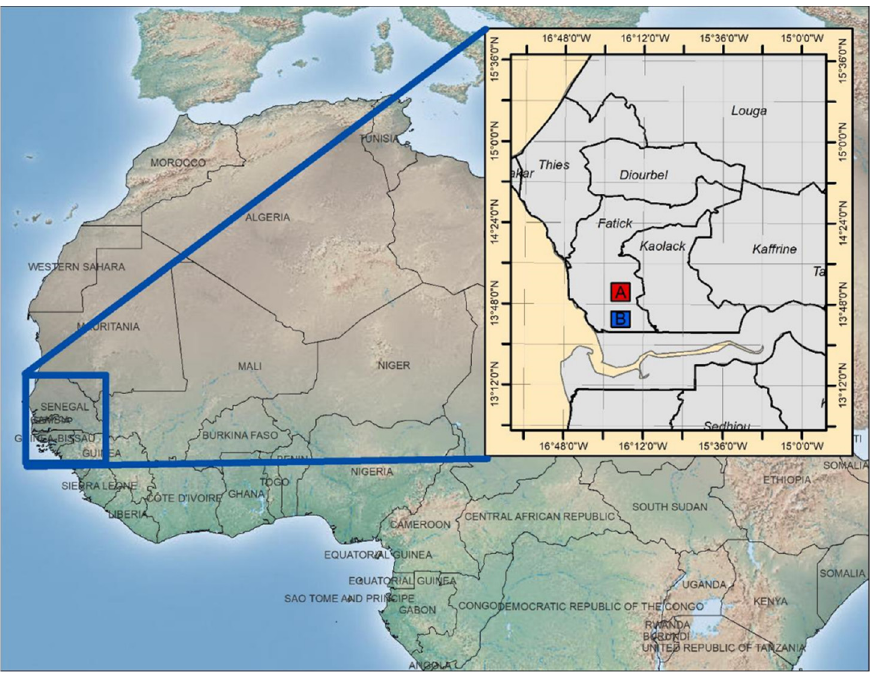
Figure 1. Location of the study site in the Sudano-Sahelian zone of Senegal. (A) The red box indicates the location of the data collection in the vicinity of Sokone. (B) The blue box indicates the location of validation, vicinity of Karang.